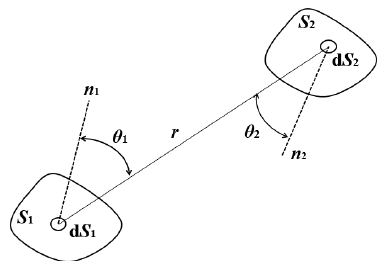
Figure 2. Illustrative diagram of view factor calculation between two areas.